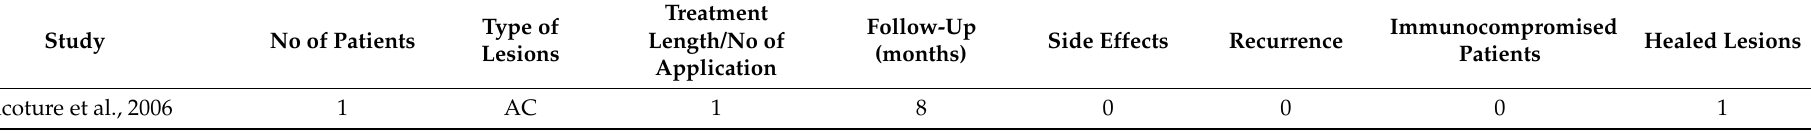
Table 9. Mohs Micrographic surgery studies.